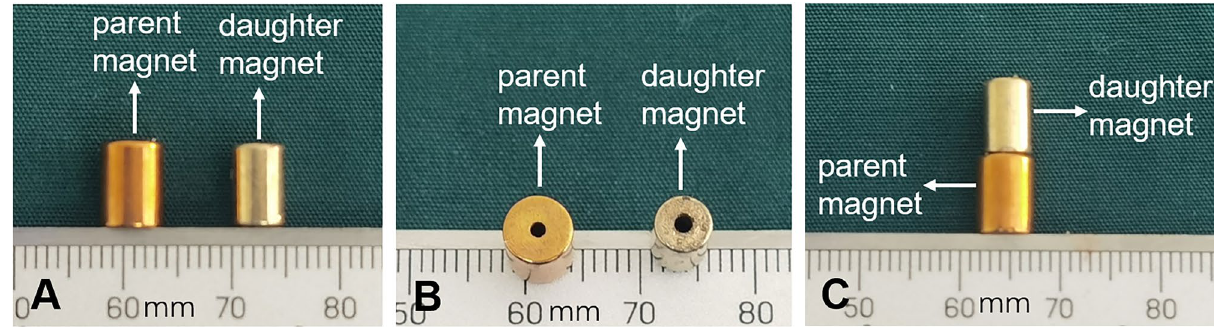
Figure 1. Photographs of the parent magnet and the daughter magnet. ( A ) Side view of the magnets. ( B ) Bottom view of the magnets. ( C ) Side view of the two magnets attracted